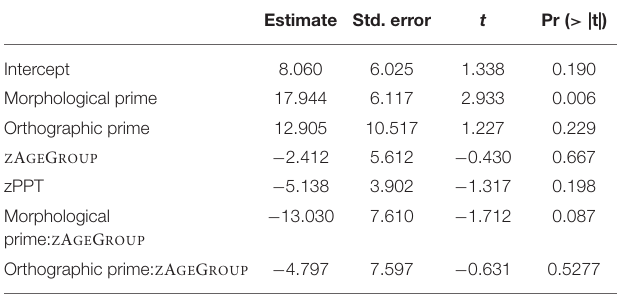
TABLE 5 | Lmer model for priming effects with fixed effects of P RIME T YPE , Z A GE G ROUP and zPPT as well as the interaction between P RIME T YPE and Z A GE G ROUP